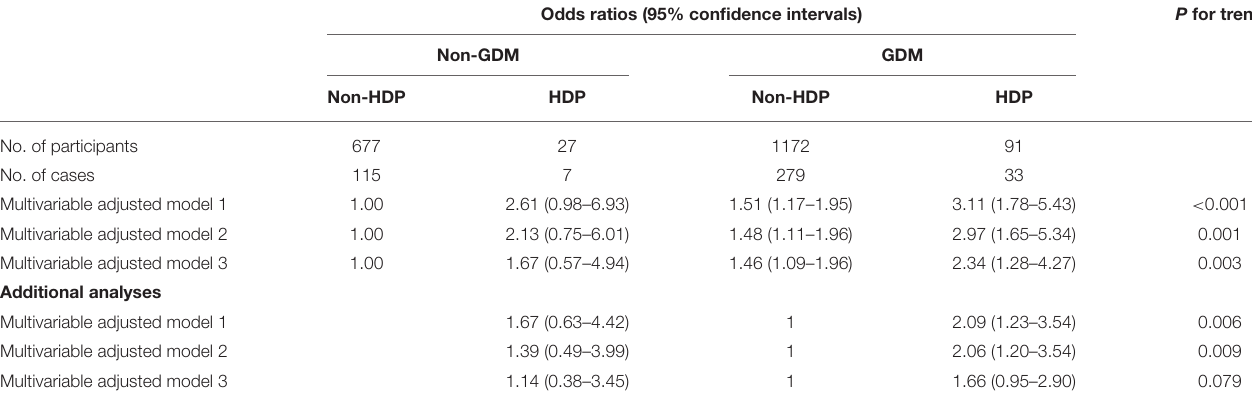
TABLE 3 | Odds ratios for childhood overweight according to maternal gestational diabetes and hypertensive disorders of pregnancy. Odds ratios (95% confidence